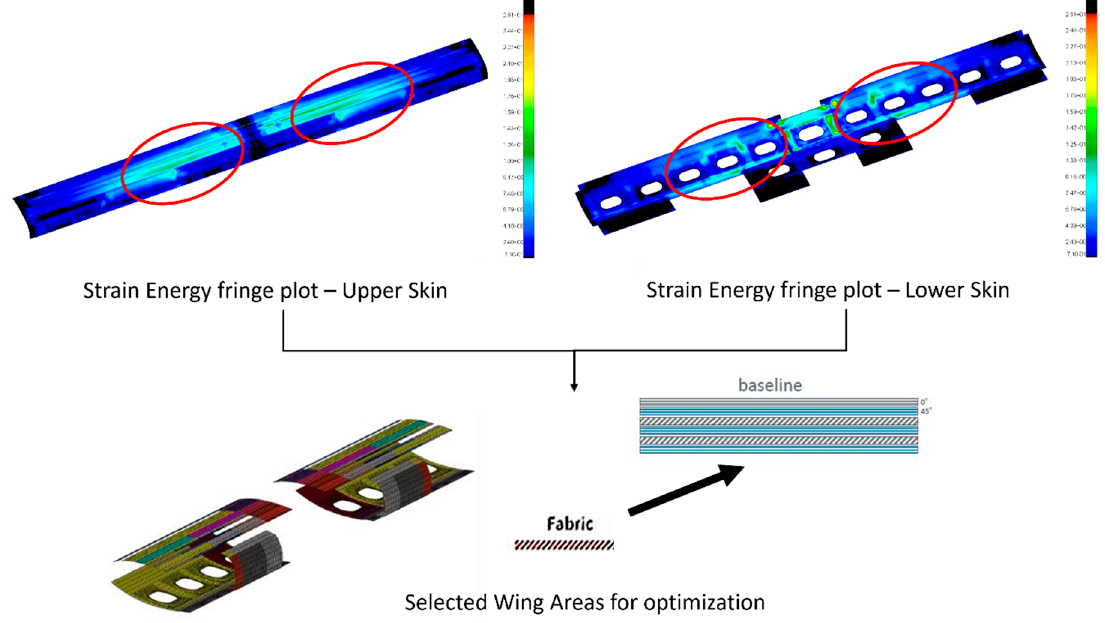
Figure 7. Identification of wing areas for torsional stiffness improvement . Table 3. Wing Dynamic Status: Aircraft Flexural and Torsional Modes for the added ±45° fabric layers models in the AP mode .